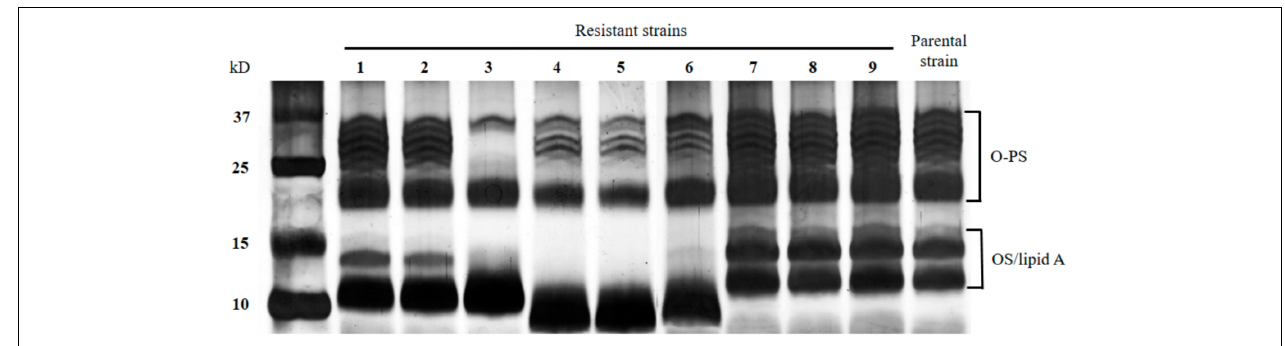
FIGURE 4 | LPS profile. The LPS components of the mutants resistant to CHOED phage and the parental PF4 strain were separated by 18% SDS-PAGE and stained with silver nitrate. The molecular weight marker KaleidoscopeTM (BIORAD) was included in the first left lane, whose sizes are shown in the figure. (1) PF4-R1, (2) PF4-R2, (3) PF4-R3, (4) PF4-R4, (5) PF4-R5, (6) PF4-R6, (7) PF4-R7, (8) PF4-R8, (9) PF4-R9 and (10) parent PF4